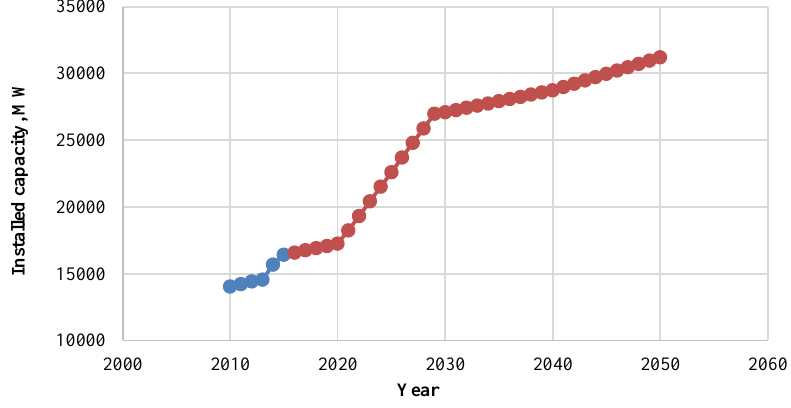
Fig. 5. Demand for electrical power until